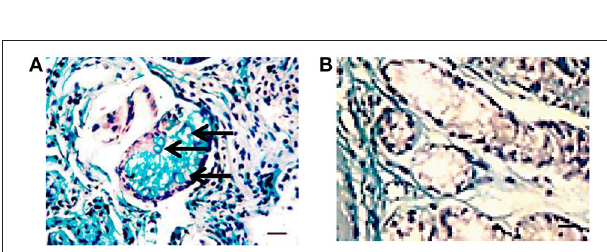
FIGURE 2 | Histochemistry of gastric epithelium metaplasia in a H. pylori positive biopsy. Gastric biopsy sections (3–5 µ m) were deparaffinized and stained with Alcian blue (pH 2.5) and PAS followed by H&E staining. Presence of sialomucins (stained blue, solid arrow) demonstrates incomplete metaplasia ( Filipe et al., 1994). (A) H. pylori positive gastric biopsy; (B) H. pylori negative gastric biopsy (Bar represents 20 µ